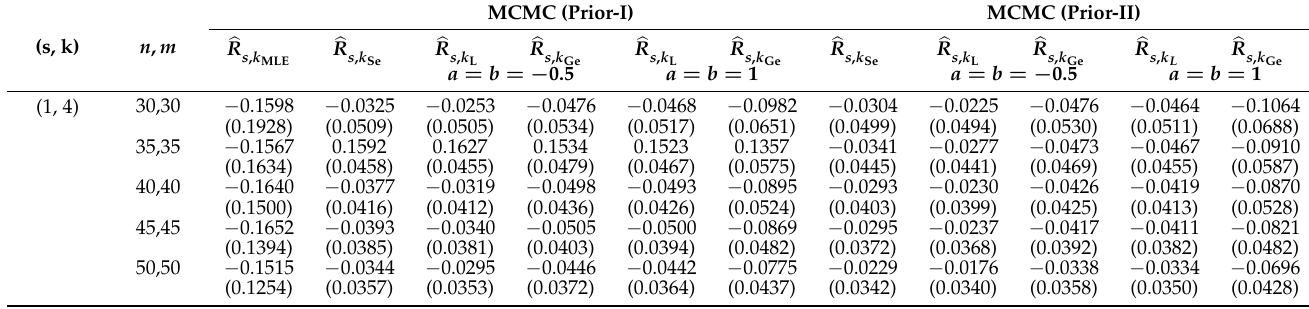
Table 4. The rBias and rMSE (in parentheses) for Case 2, ( α , λ 1 , β , λ 2 ) = ( 2, 2, 2, 3 ) and T =